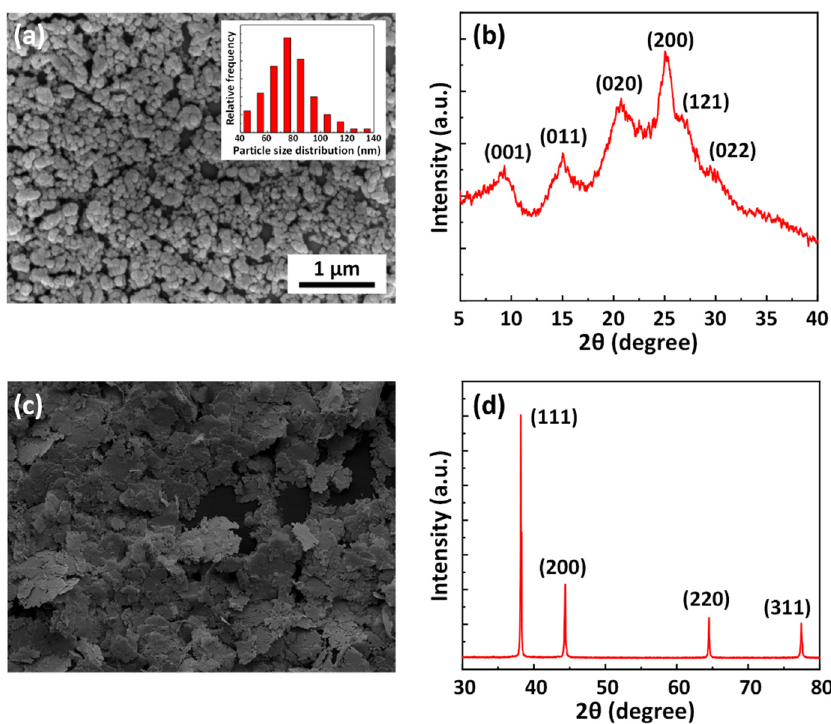
Figure 1. ( a ) SEM image of as-prepared nano-structure PANIs (insert: diameter distribution of PANI nanoparticles); ( b ) XRD spectra of as-prepared PANI materials; SEM image ( c ) and XRD spectra ( d ) of silver